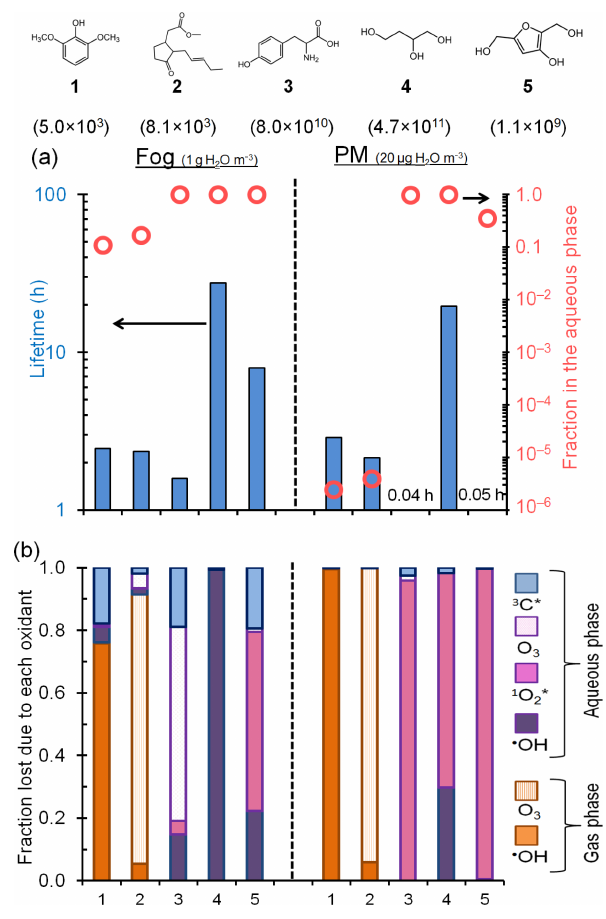
Figure 6. Fate of five model organic compounds – (1) syringol, (2) methyl jasmonate, (3) tyrosine, (4) 1,2,4-butanetriol, and (5) 3- hydroxy-2,5-bis(hydroxymethyl)furan – under liquid water content conditions for fog (left of vertical dashed line; 1gH 2 O/m 3 air) and PM (right of line; 20µgH 2 O/m 3 air). Estimated Henry’s law con- stants for the compounds (in units of Matm − 1 ) are in parentheses beneath each structure. In panel (a) the columns represent overall lifetimes of the organics and the open circles represent the frac- tions in the aqueous phase. Panel (b) shows the fraction of each compound lost via various gas and aqueous pathways. The triplet contribution in PM is estimated using the lower-bound triplet con- centration extrapolation, i.e., 1 . 3 × 10 − 13 M (Fig. 5). Oxidant con- centrations and rate constants are in Tables S16 and